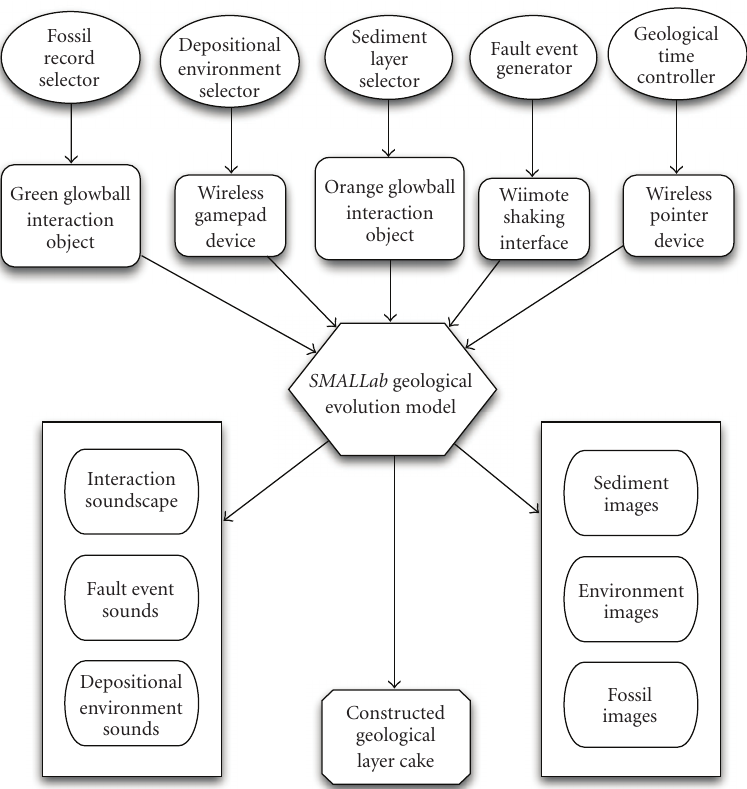
Figure 4: Layer-cake builder interaction architecture schematic.